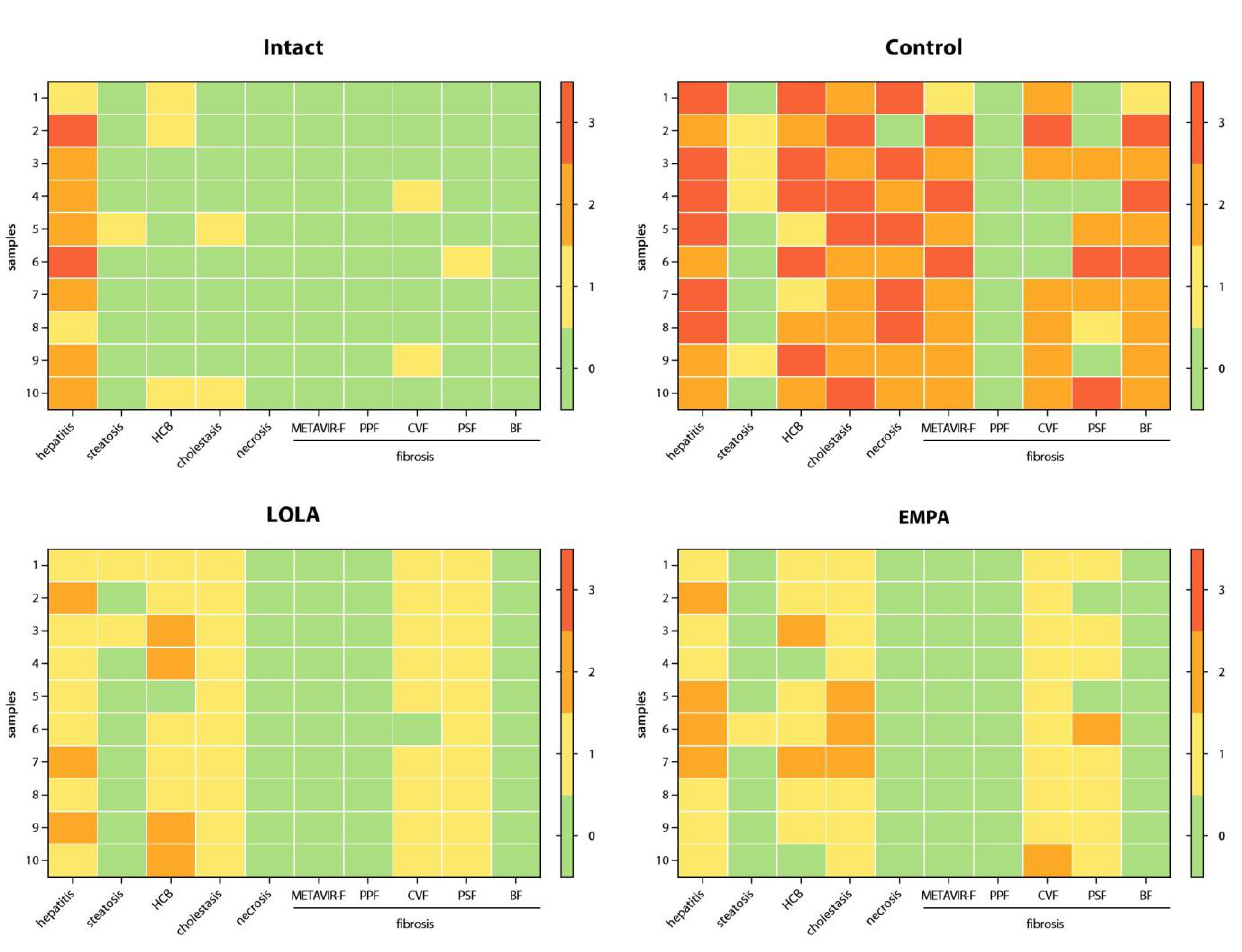
Figure 5. Heatmaps representing the scores obtained for all histological parameters for all liver tissue samples. HCB, hepatocellular ballooning; PPF, periportal fibrosis; CVF, central vein fibrosis; PSF, perisinusoidal fibrosis; BF, bridging fibrosis.